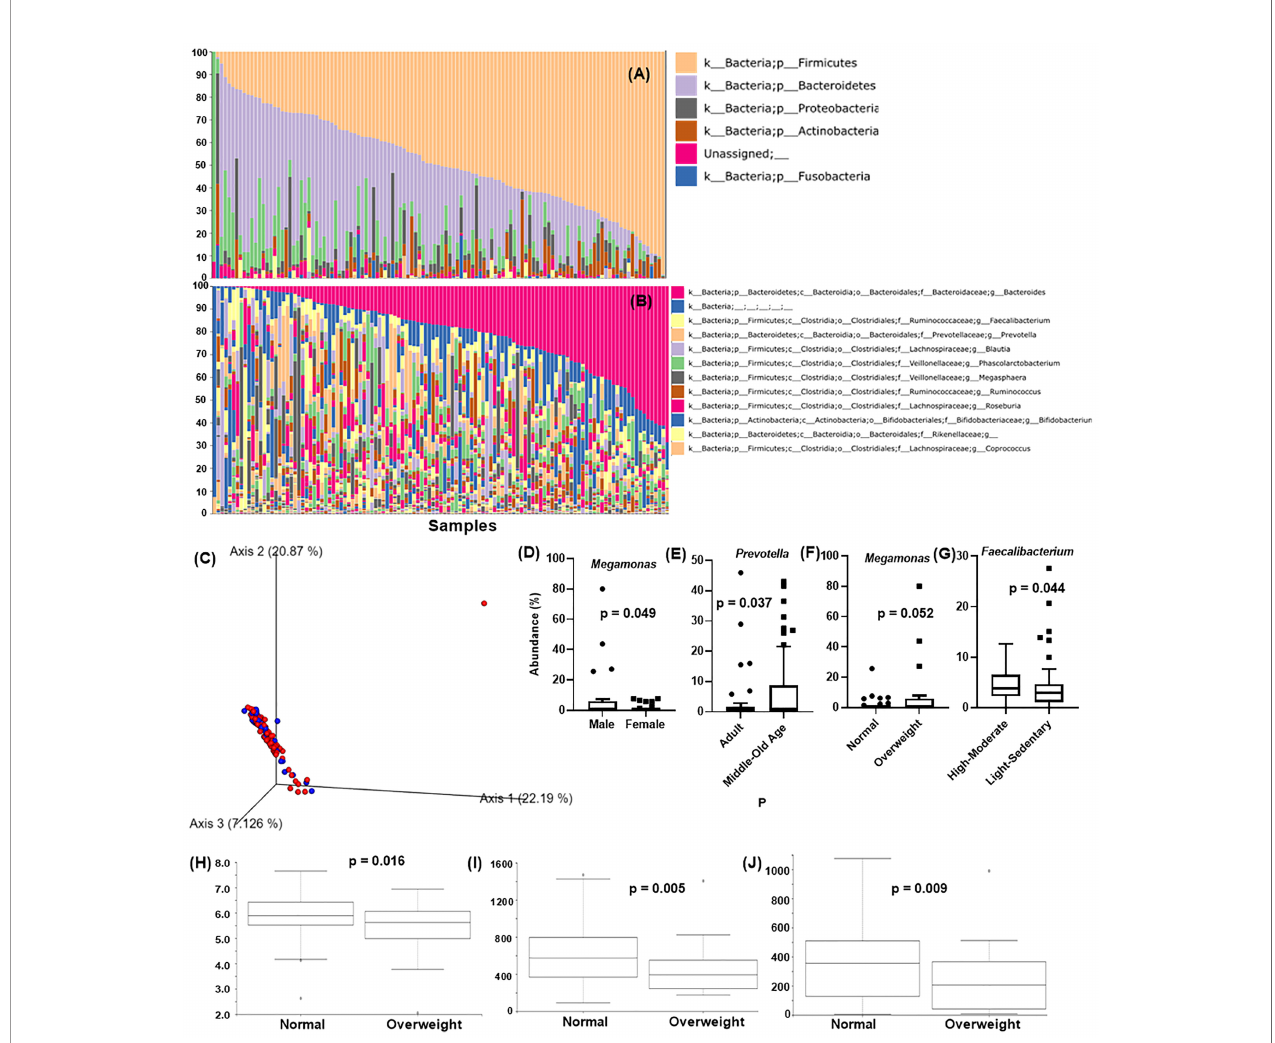
FIGURE 1 | Analysis of Taiwanese Microbiome Baseline. Taxonomic classi fi cation at the (A) phylum level and (B) genus level. X-axis: individual samples (N=119), y-axis: percentage of bacteria in individual samples. (C) PCoA of the beta diversity values based on weighted UniFrac at the gender level. Blue = male, red = female. Analysis of the differentially abundant bacterial genera identi fi ed by (D) gender, (E) age, (F) BMI, and (G) physical activity. X-axis: evaluated demography, Y-axis: average abundance percentage. Alpha diversity for BMI using (H) Shannon ’ s index (I) observed_OTUs (J) faith_pd. Y-axis: alpha diversity indices in the respective